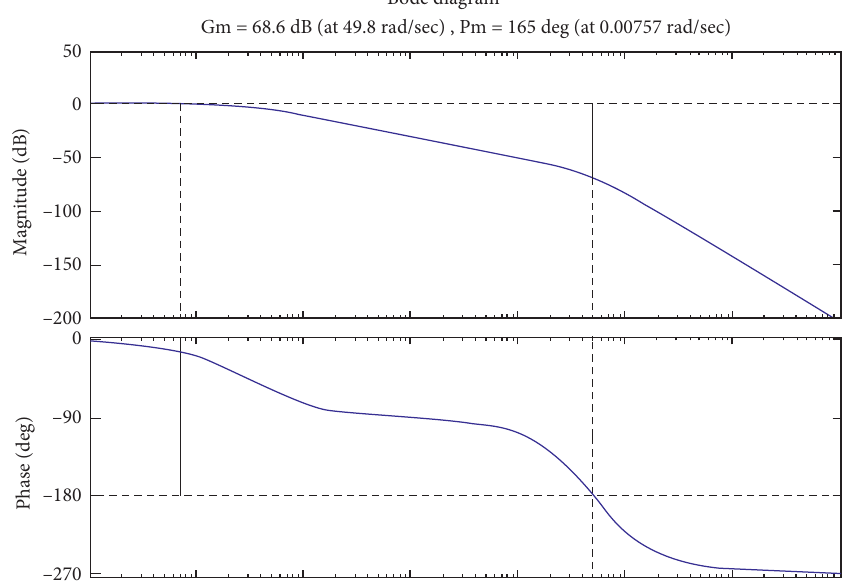
Figure 4: The Bode plot.